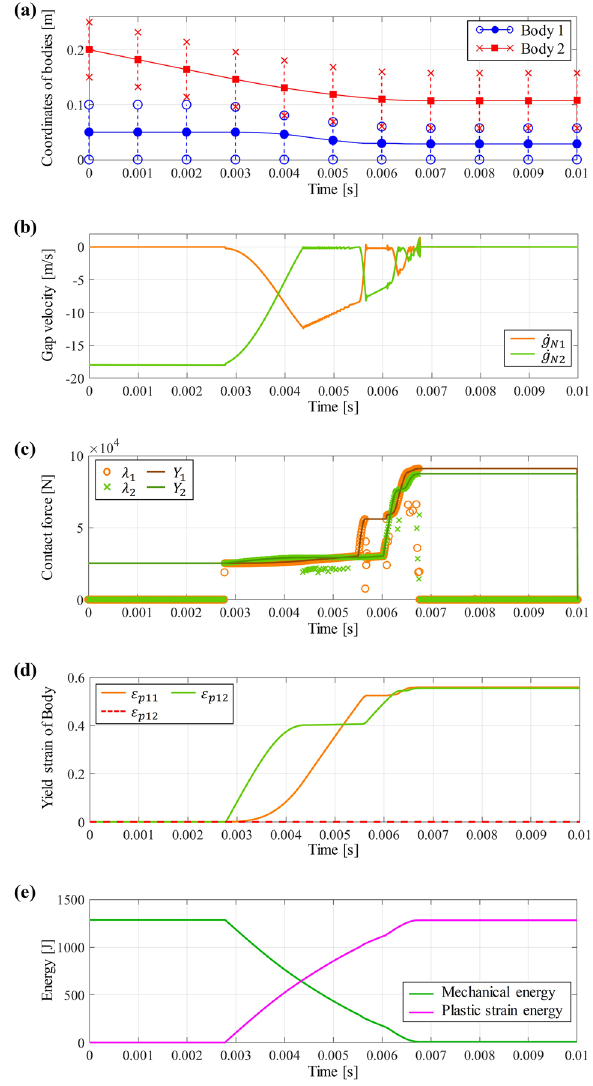
Fig. 10 Case 2: a Coordinates; b Gap velocity; c Contact force; d Yield strain; e